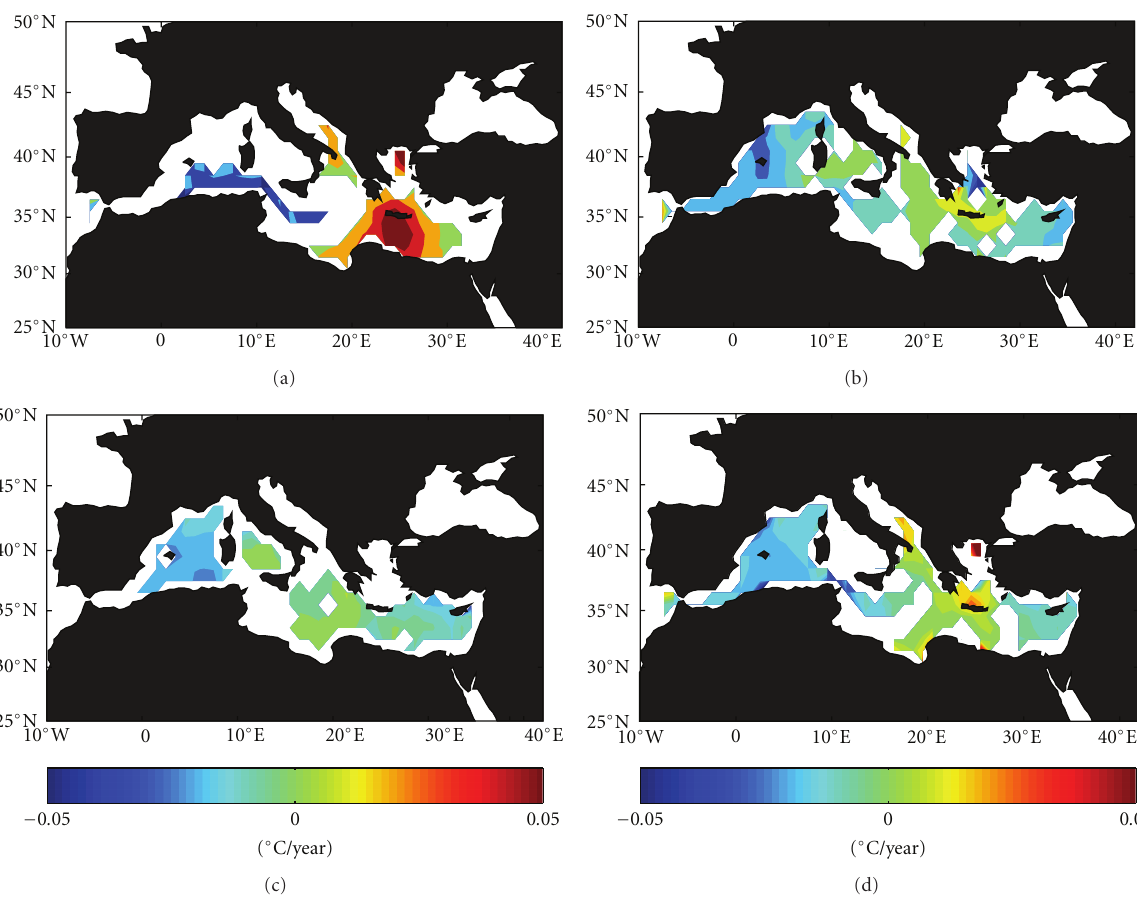
Figure 2: Spatial distribution of the temperature trend from the ECCO model data (93–09) for the di ff erent layers: (a) surface layer (0– 150m), (b) intermediate later (150–600 m), (c) deep layer (600m–bottom), and (d) entire water column.